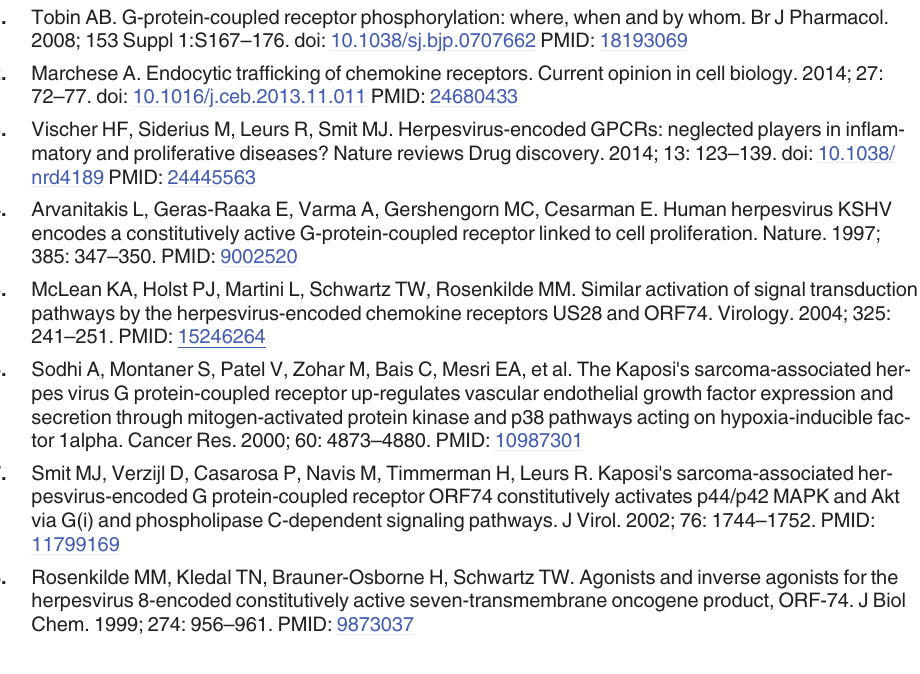
(B), Venus-Rab7a (late endosome/lysosome marker) (C), Venus-Rab11 (recycling endosome marker) (D) and stimulated with CXCL1, CXCL8 or CXCL10 for indicated time and BRET was measured. Data are shown as the mean of pooled data from three independent experi- ments each performed in triplicate. Data is presented as fold over vehicle-stimulated cells (dot- ted line) and error bars indicate SEM values. Statistical differences between the area under the curve of vehicle- and corresponding CXCL1-, CXCL8 or CXCL10-treated cells (baseline = 1) were determined by one-way ANOVA followed by a Bonferroni test. NS = not significant. (TIF) S5 Fig. Helix 8 is not always present in class A GPCR crystal structures and shows variabili- ty in orientation and length. (A) Sequence overview highlighting the secondary structure of TM7 (marked gray) and helix 8 (marked red) in all crystal structures. The sequences shown are from the crystallographic constructs with indicated PDBs. Grey residues were not resolved in the crystal structure. (B) An alignment of the end of TM7 and the full C-tail of a single crystal structure per crystallized class A GPCR based on the conserved NPxxY motif in TM7.